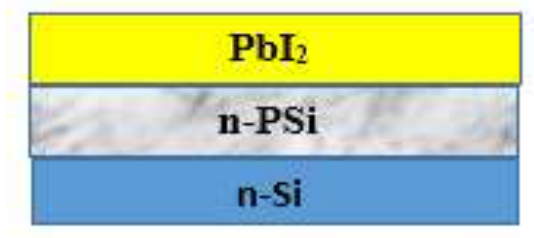
Figure 4 : Across-section view of the prepared n-Si/n-PSi/PbI 2